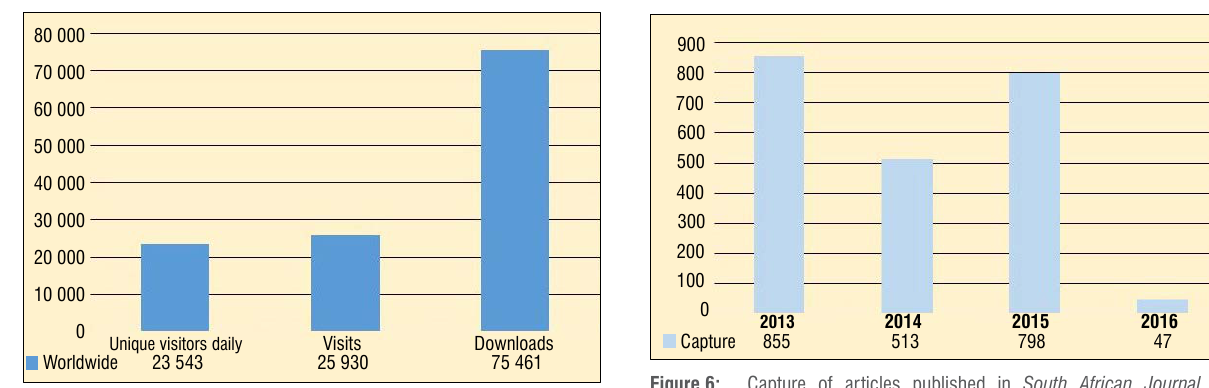
Figure 3: User visits and downloads worldwide for the South African Journal of Libraries and Information Science , 2012–2017.